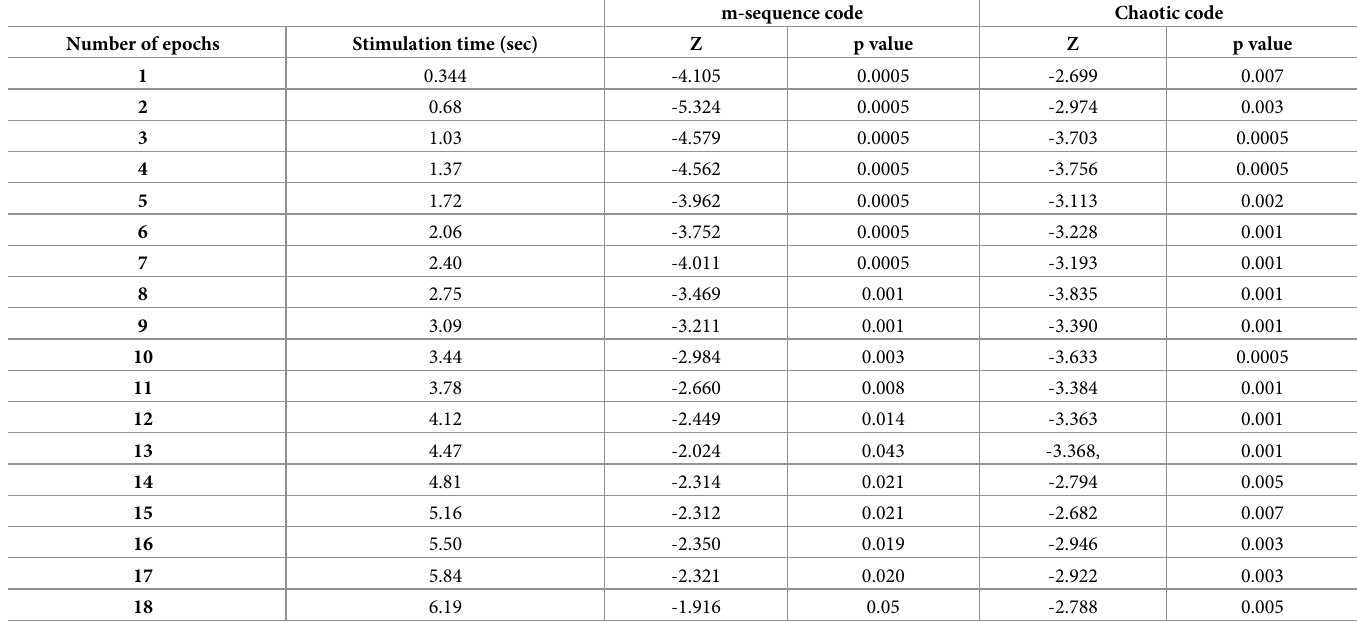
Table 3. Statistical results for accuracy values of paired t-test in the comparison between STB and CCA methods for m-sequence and chaotic codes. m-sequence code Chaotic